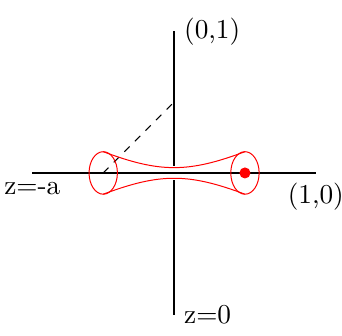
Figure 14 . Toric diagram for the deformed conifold with M D-branes on M . Note that we have not specified the frame of the probe D-brane on M